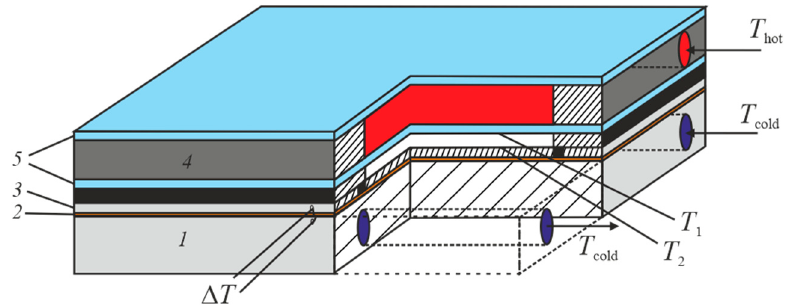
Figure 2. Scheme of the experimental cavity.